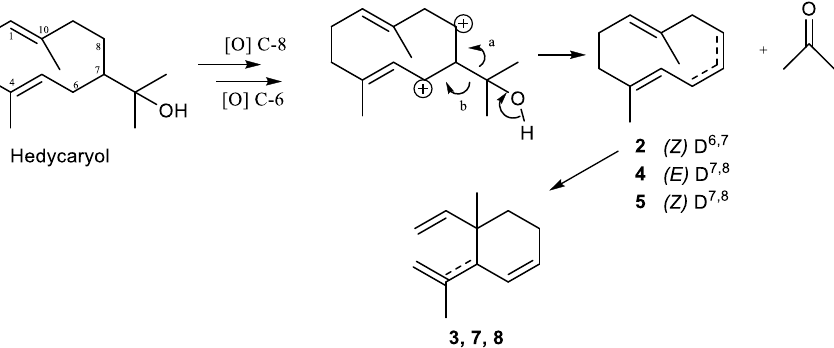
Figure 10. Proposed mechanism for biosynthesis of tri- nor -germacranes 2, 4 and 5, and tri- nor - elemanes 3, 7 and 8 . elemanes 3, 7 and